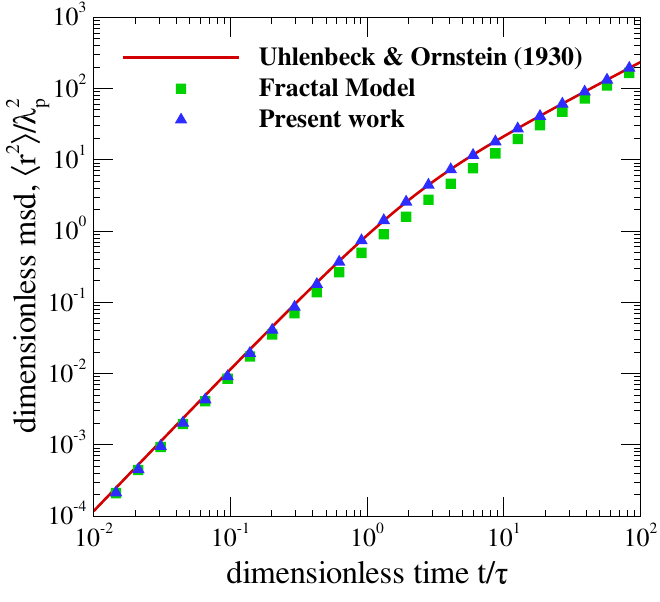
Figure 2. Approximation of the normalized mean squared displacement (MSD) normalized by the squared Fuch’s persistent distance λ 2 p = 8 D τ / π as a function of the dimensionless time where τ is the momentum relaxation time. The proposed method given by Equation (13) is compared with [28] given by Equation (11) and the fractal model proposed by